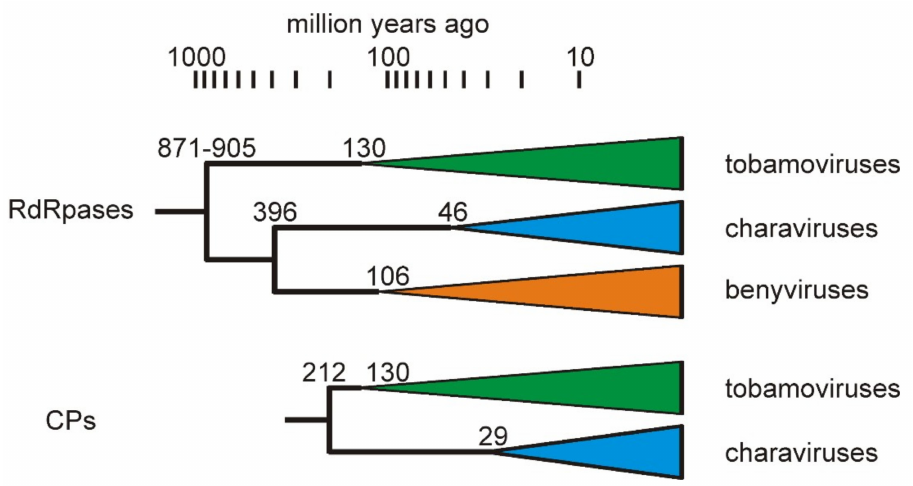
Figure 7. Summary of the estimates of gene divergence dates (million years before present) for the charavirus, tobamovirus, and benyvirus RdRp and CP proteins. The coloured triangles represent monophyletic clusters (i.e., two or more homologs) of the proteins found in extant viruses, and their left hand tip represents the earliest likely age of each extant virus cluster.